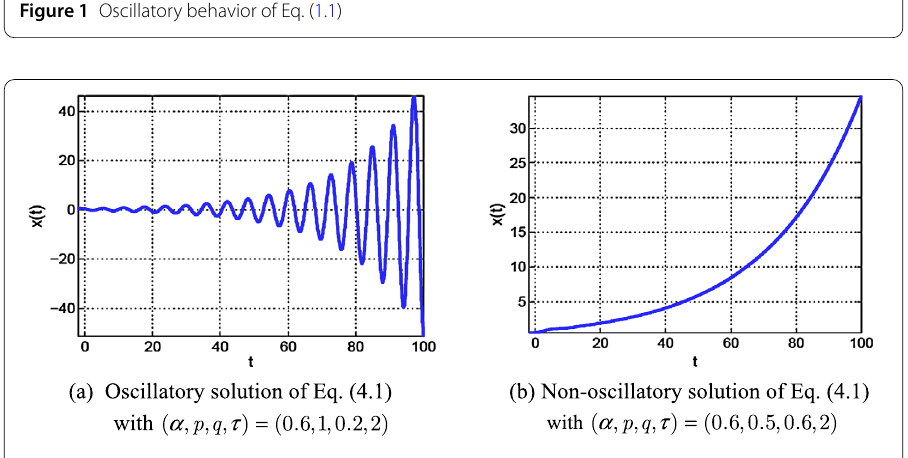
Figure 1 Oscillatory behavior of Eq. (1.1)